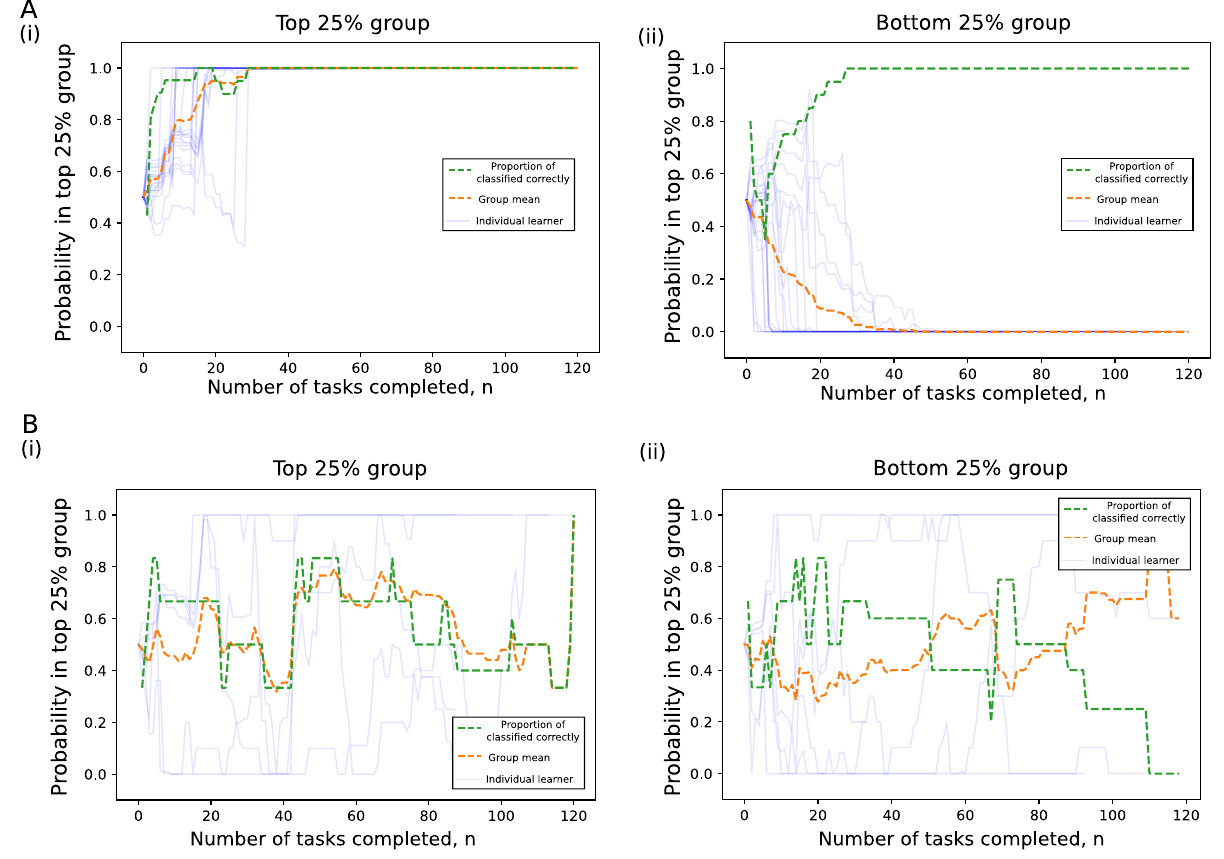
Figure 7. Application of Bayesian probabilistic model to learn sequence trajectories. ( A ) Probability that each learner in top 25% belongs to top 25% (i) and the probability that each learner in the bottom 25% belongs to top 25% (ii) using averages across posterior samples trained on data from the respective groups. Each learner is a blue line, the mean across all learners an orange dashed line and the proportion over 0.5 as a green dashed line. After around 30 tasks the probability goes to unity and zero respectively for the two test groups providing indication that the probabilistic model is able to learn differences between the two groups. ( B ) The top plots utilized data included in the training dataset for testing, while the bottom plots train with 70% of the learners from each group and test on the remaining 30% from each group. This indicates whether the learned model can differentiate unseen learners giving it true predictive utility. There is much greater variability in the position of the each learner’s blue line, but on average the orange and green lines lie above and below the 0.5 threshold indicating there is some predictive power. Interestingly, the strongest predictive region seems to be in the gap where coursework is completed later after completing more of the course, a trend observed in the higher performing group. The predictive power weakens at large n due to fewer training and test samples completing that many